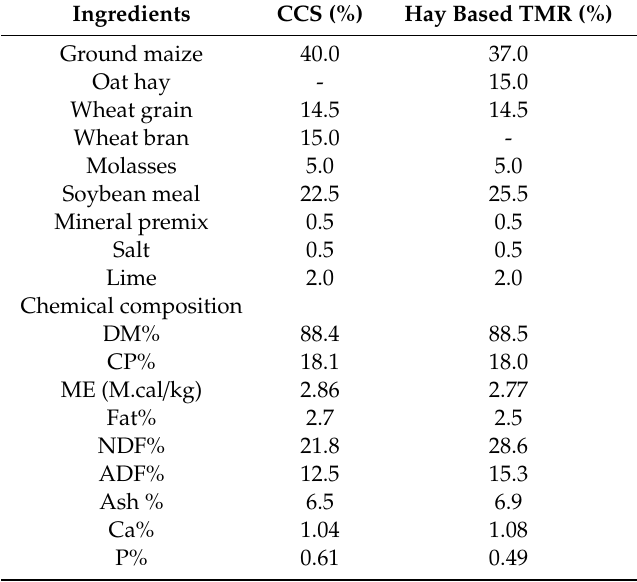
Table 1. Ingredient composition of starter feed and total mixed rations used in the preweaning